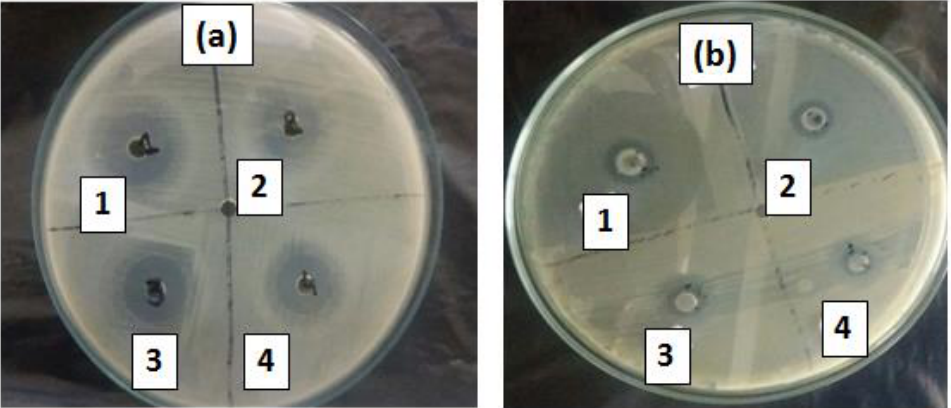
Figure 9. Usage of ( a ) rGO-ZnS-Ag, ( b ) rGO-ZnS nanocomposite against Eschericia coli. [(1) 2 mg/mL, (2) 1 mg/mL, (3) 0.5 mg/mL, and (4) 0.25 mg/mL.].